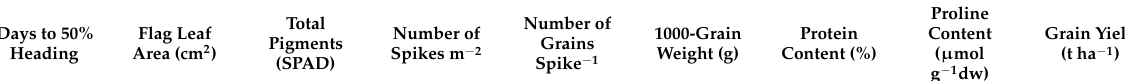
Table 7. Simple correlation between grain yield (t ha − 1 ) and the other important physiological and agronomic characters (combined data over two